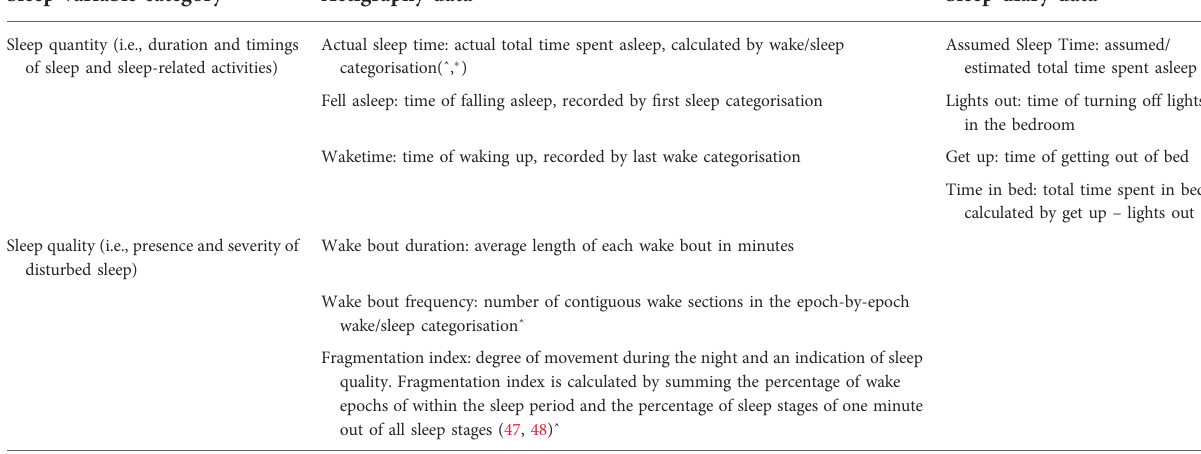
TABLE 1 Sleep variables measured by actigraphy and sleep diary data. Sleep variable